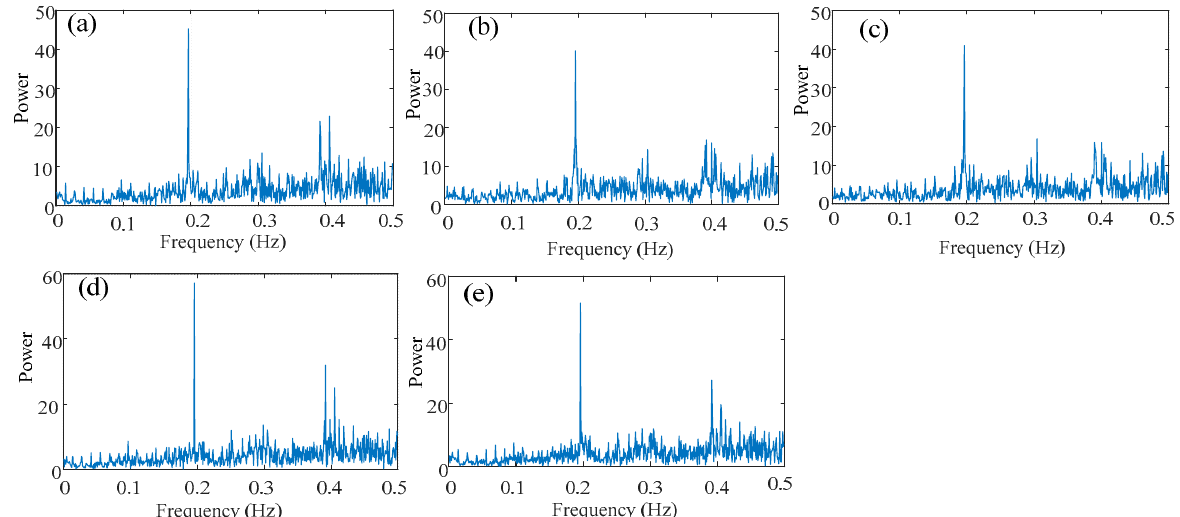
Figure 8. FFT transform results of transient mass signals at different liquid flow rates: ( a ) 10/g · min − 1 ; ( b ) 20/g · min − 1 ; ( c ) 30/g · min − 1 ; ( d ) 40/g · min − 1 ; ( e ) 50/g · min − 1 .